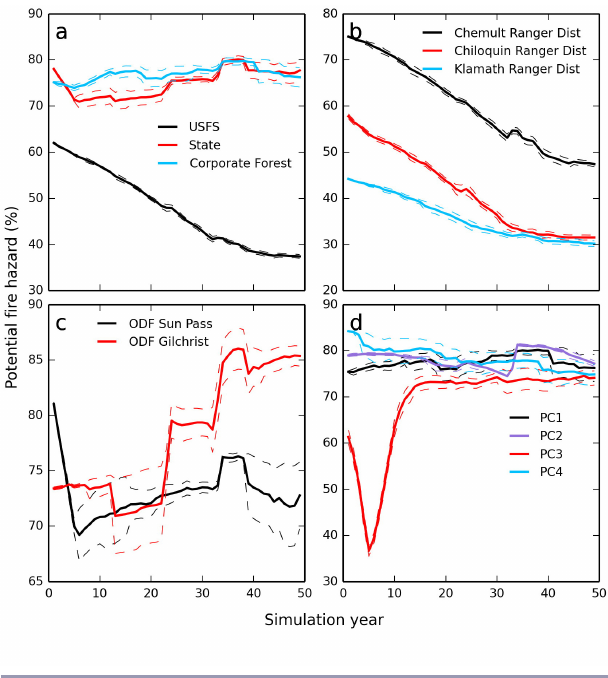
Fig. 6. Mean annual area (percentage) and 95% confidence interval (dashed lines) of potential high-severity fire (hazard) under current management vs. time, between and within ownership categories. Based on 15 model